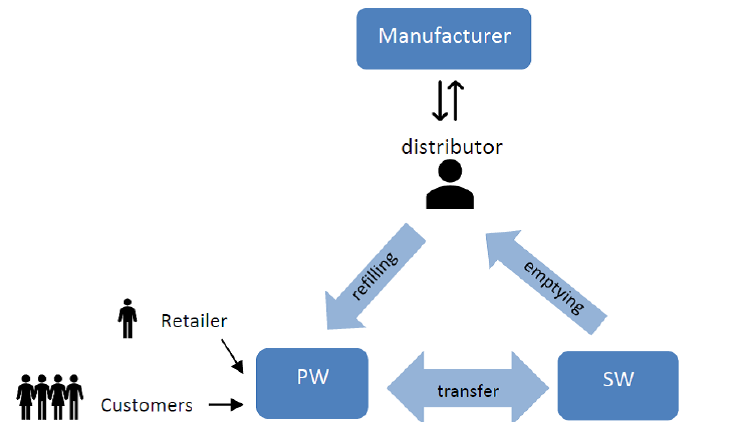
Figure 1. The relationship between the manufacturer, distributor, customers, and